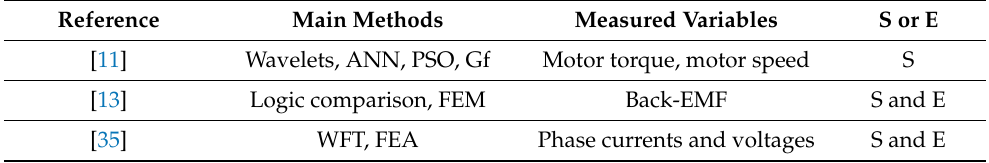
Table 3. Data-based methods for diagnosing inter-turn faults.